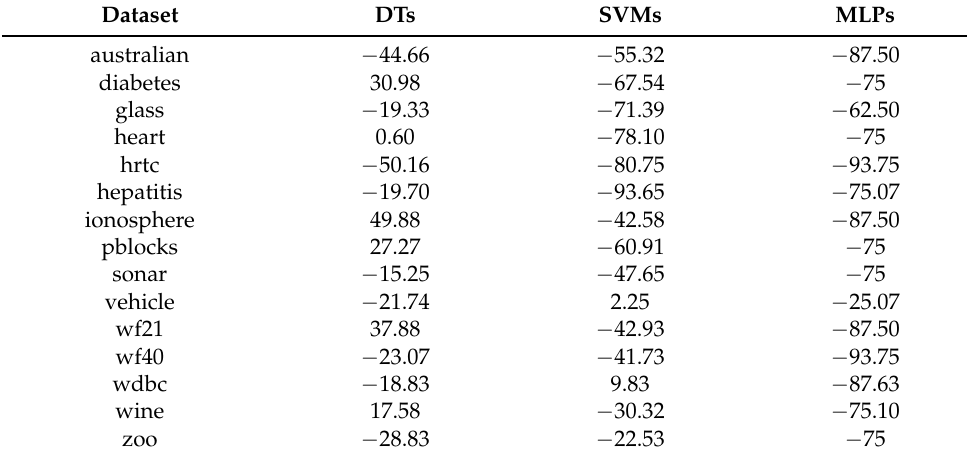
Table 10. SRMLC memory storage reduction compared to RMLC [33], expressed in % as a result of sparse data representation.